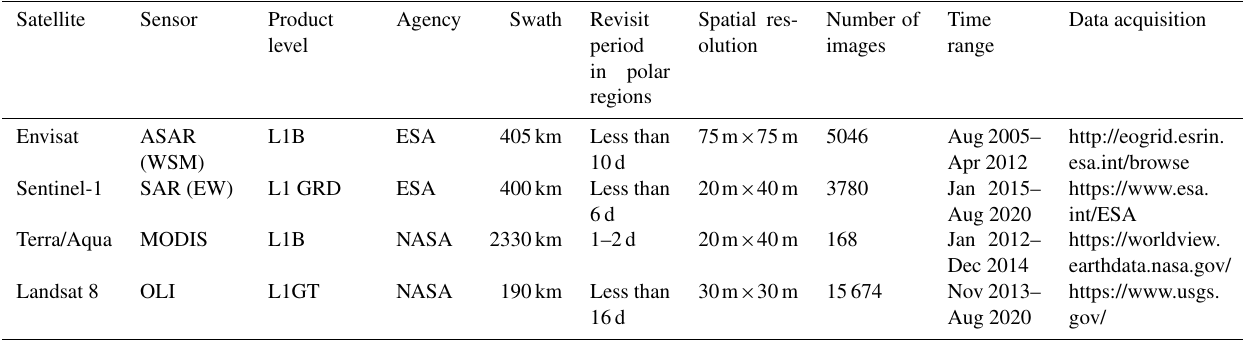
Abbreviations: ESA denotes the European Space Agency, and NASA denotes the National Aeronautics and Space Administration.